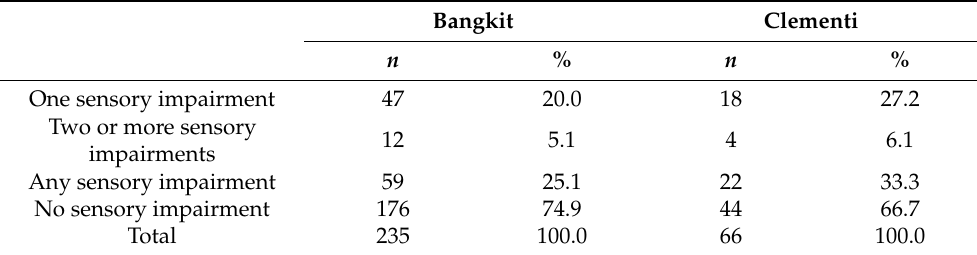
Table 2. Reported sensory impairments (regardless of age).